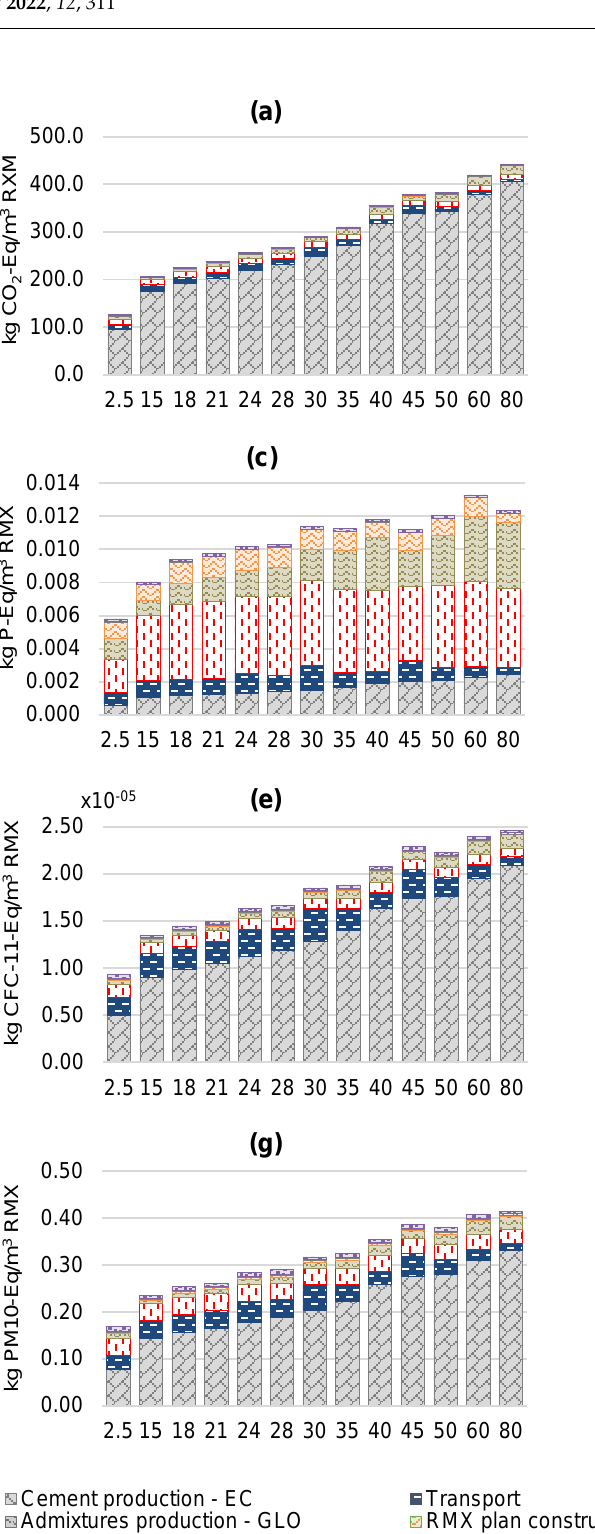
Figure 4. Characterization of results for impact categories. The graphs show the impact results per m3 of ready-mixed concrete (functional unit) with compressive strength between 2,5 and 80 MPa and a contribution analysis for processes. (a) Global warming potential — GWP100; (b) Terrestrial acidification potential — TAP100; (c) Freshwater eutrophication potential — FEP; (d) Marine eutrophication potential — MEP; (e) Ozone depletion potential — ODPinf; (f) Photochemical oxidant formation potential — POFP; (g) Particulate matter formation potential — PMFP; (h) Fossil depletion potential — FDP; RMX: ready-mixed concrete; EC: Ecuador; GLO: global; and RoW: Rest of world.